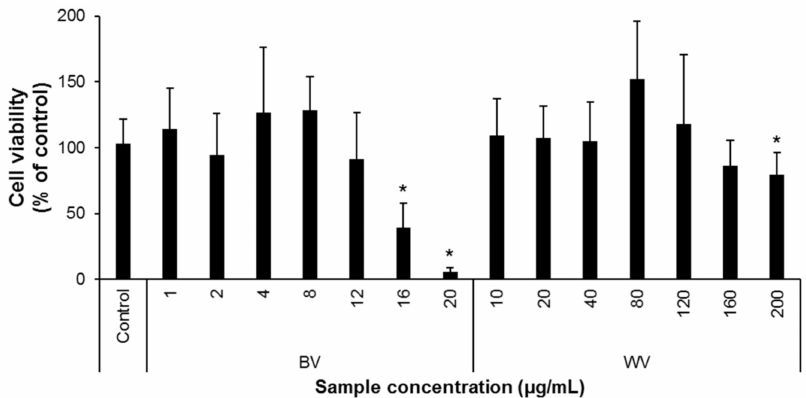
Figure 1. Cytotoxicity of bee venom (BV) and wasp venom (WV) in BV-2 microglial cells. BV-2 cells were plated into a 96-well plate at a density of 5 × 10 3 cells/well and were treated with either BV or WV at the designated concentrations for 24 h. The cell viability was then assayed using the CCK-8 kit. BV and WV were non-toxic at concentrations of ≤ 12 µ g/mL and ≤ 160 µ g/mL, respectively. Independent experimental sessions ( N ) = 5; error bars, mean ± standard deviation (SD). Asterisks (*) indicate a statistically significant difference compared to the control ( p < 0.05; Student’s t